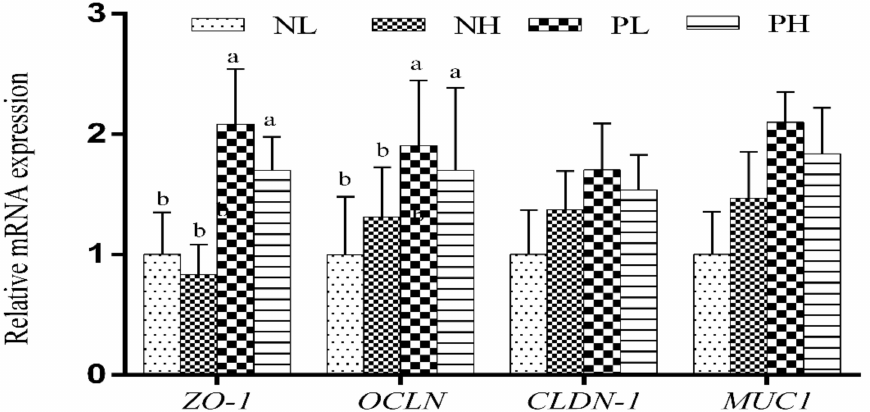
Figure 2. Effects of different moisture contents (adding 7.5 vs. 15% water) and enzyme additions (adding 4 kg/t α -amylase or not) to extruded corn on the mRNA levels of jejunal barrier-function- related genes in weaning piglets. Each column represents the mean expression level with six inde- pendent replications. Letters above the bars (a, b) indicate statistical significance ( p < 0.05) of gene expression among the four treatments. NL, adding 7.5% water before corn extrusion; NH, adding 15.0% water before corn extrusion; PL, adding 7.5% water and 4 kg/t α -amylase before corn extrusion; PH, adding 15% water and 4 kg/t α -amylase before corn extrusion; ZO-1 , Zonula occludens 1; OCLN , Occludin; CLDN-1 , Claudin 1; MUC1 , Mucin